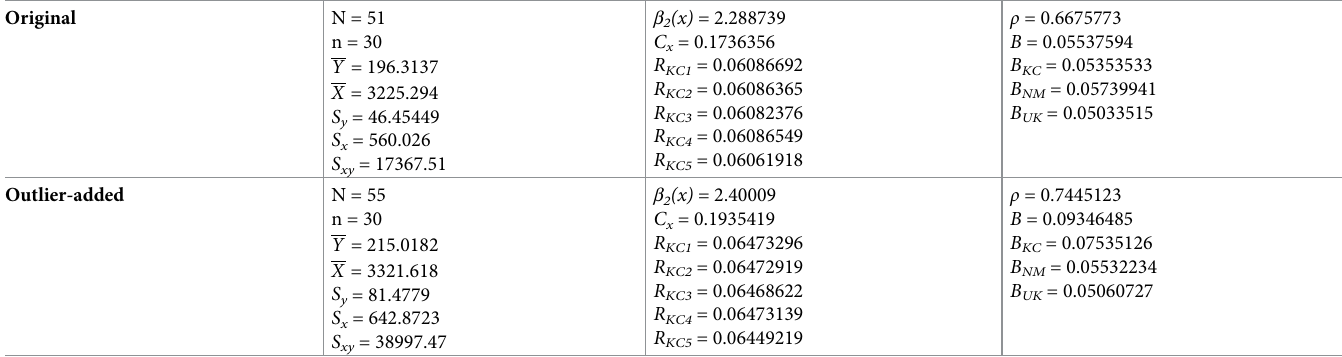
Table 3. Parameters of public school expenditures real dataset. Original